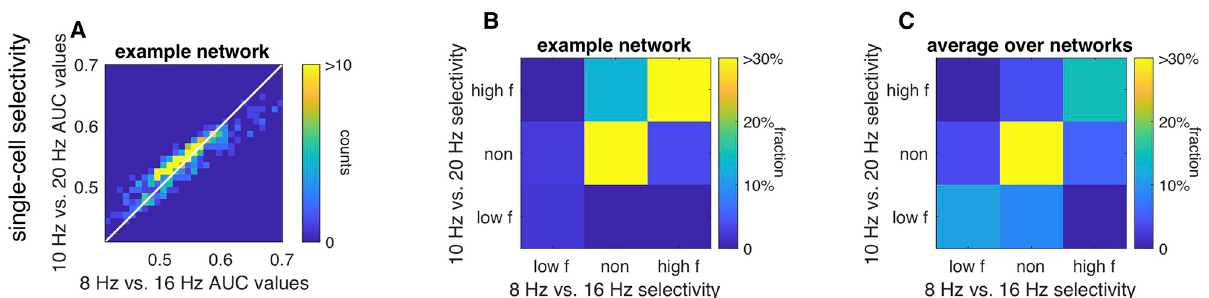
Fig 6. Changes in selectivity when input frequencies are changed. A: Density showing AUC (Fig 2A) for the 8 Hz vs. 16 Hz task against the 10 Hz vs. 20 Hz task, in the same network. Equality line is shown for reference. B: Cross-tabulation of selectivity, based on shuffle criterion. Some selective cells become non-selective, and non-selective cells become selective. C: Average cross-tabulation of selectivity across all networks.